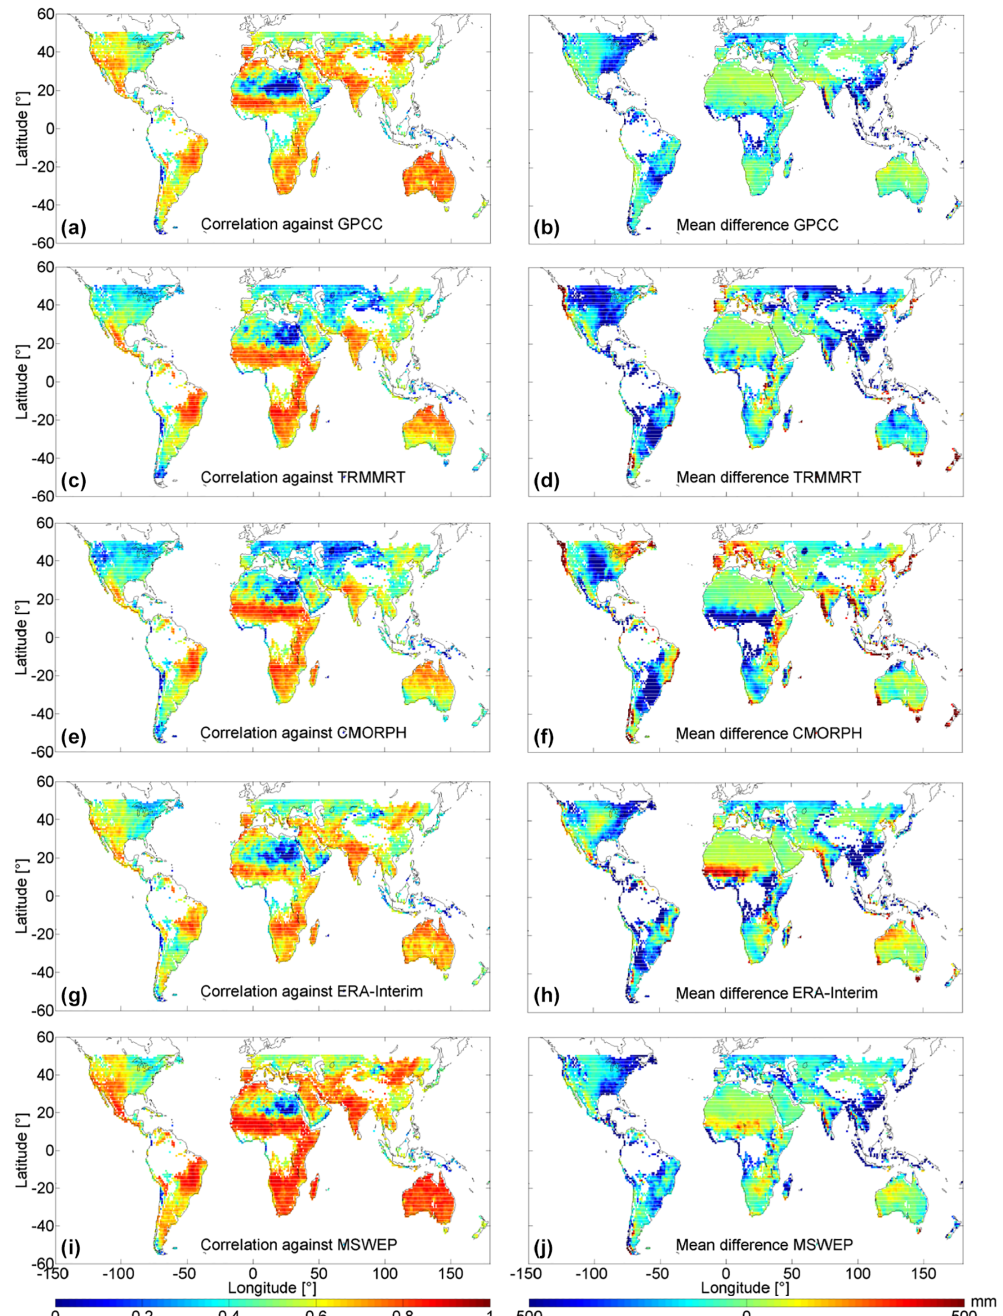
Figure 5. Correlation maps for 5 days of accumulated rainfall (left column) and differences in mean annual rainfall (right column) ob- tained by comparing (from top to bottom) SM2RAIN-CCI and GPCC (a, b) , SM2RAIN-CCI and TRMMRT (c, d) , SM2RAIN-CCI and CMORPH (e, f) , SM2RAIN-CCI and ERA-Interim (g, h) , and SM2RAIN-CCI and MSWEP (i, j) at 1 ◦ spatial resolution during the period 1 March 2000–31 December